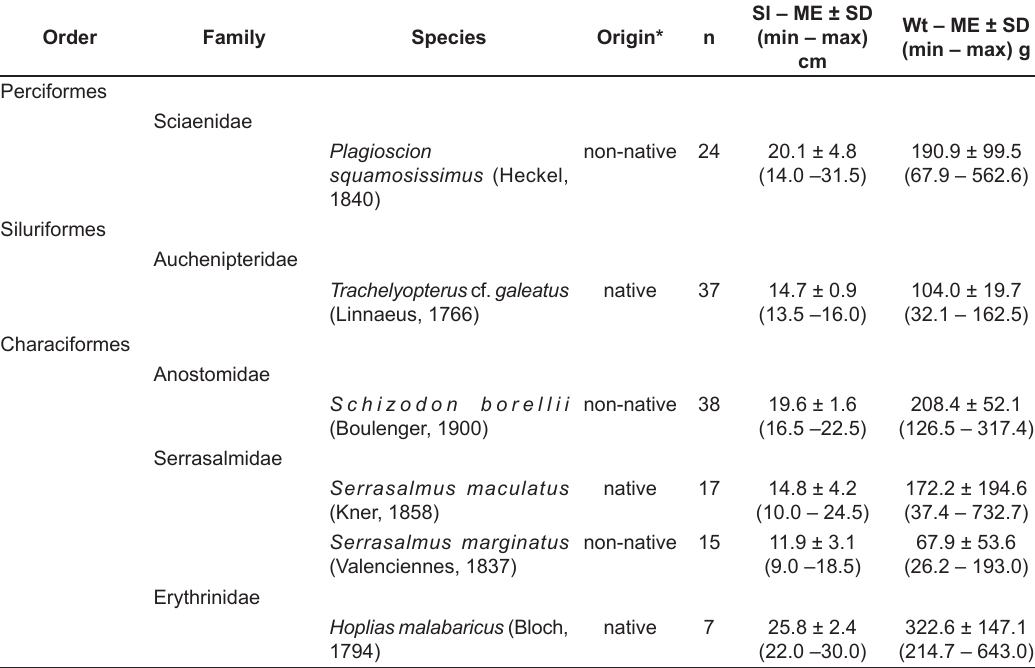
Table 2. Species, origin, number of stomachs analyzed (n), standard length (Sl), and weight (Wt) of the individuals sampled in the Refúgio Biológico de Santa Helena, Itaipu Reservoir, Paraná III River Basin, Brazil. Mean (ME) and Standard deviation (SD), followed by the minimum and maximum values.